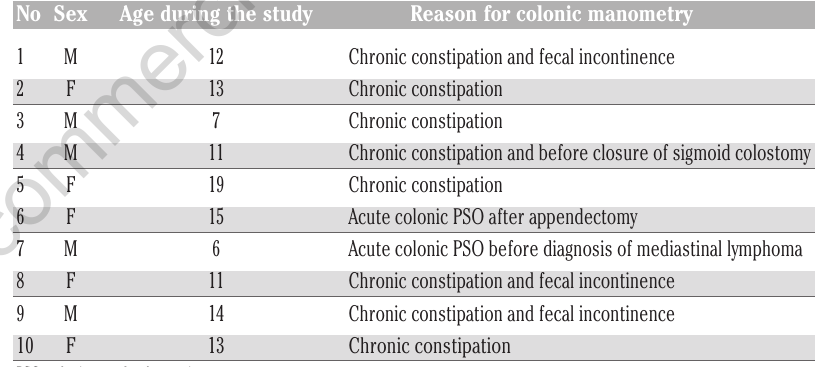
Table 2. General properties of group # 2.